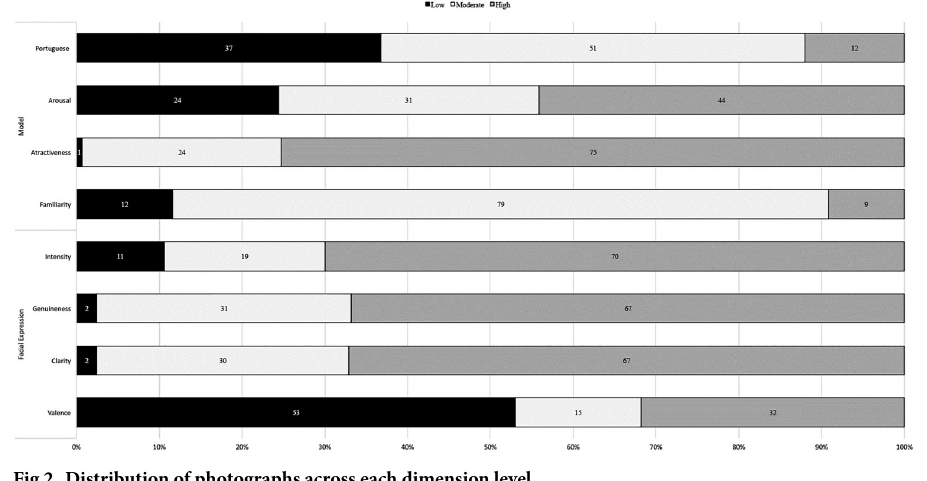
Fig 2. Distribution of photographs across each dimension